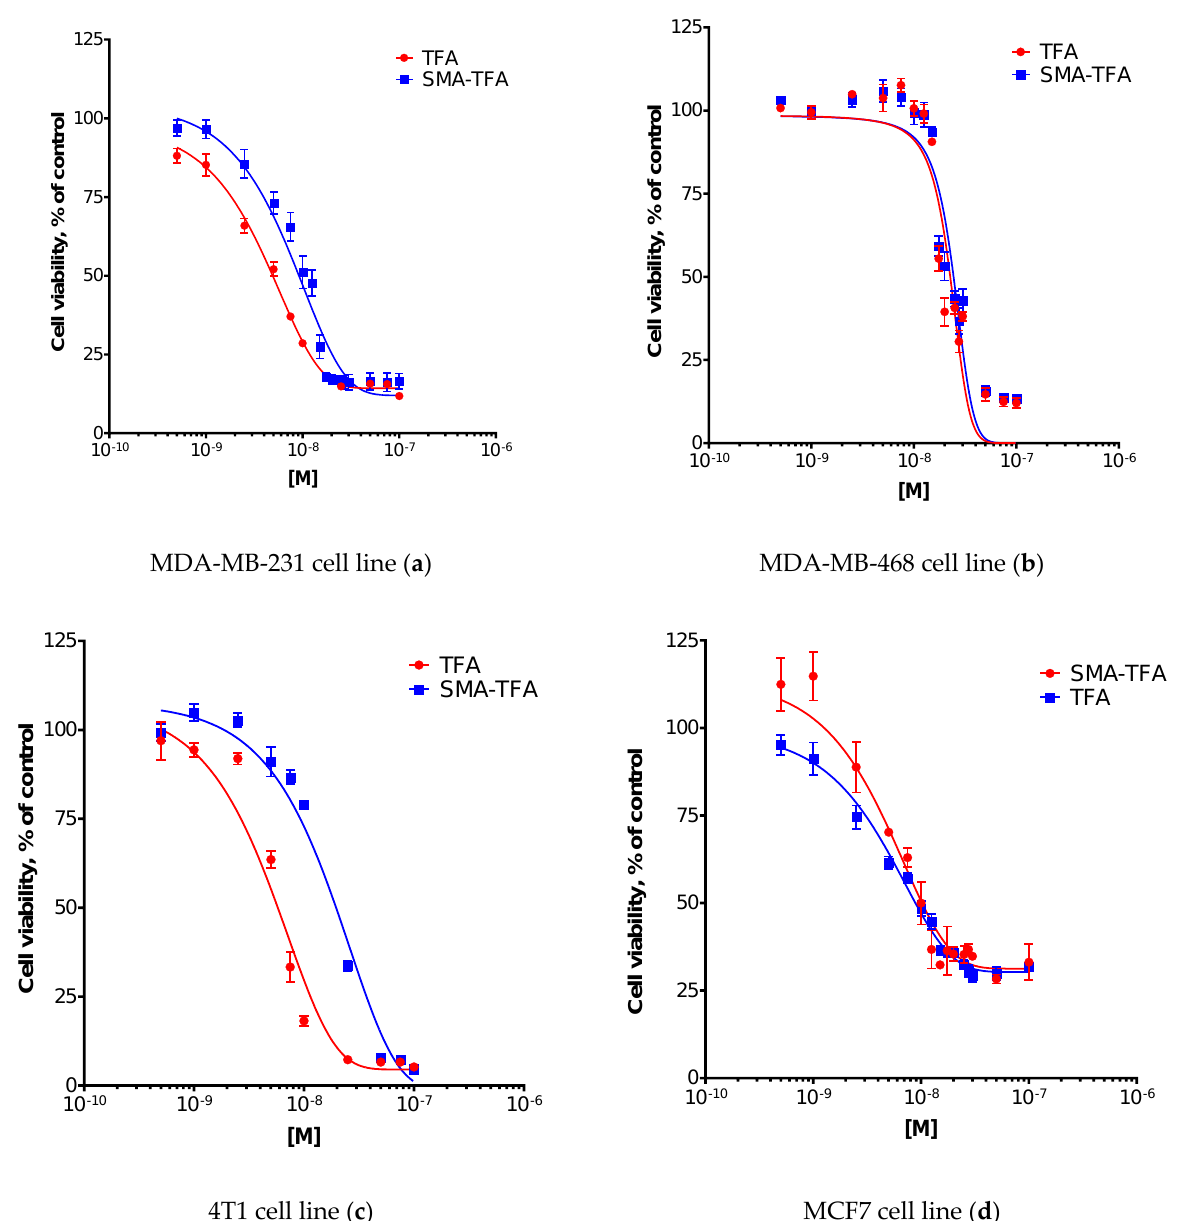
Figure 3. Cytotoxicity of TFA and SMA – TFA ( a ) against MDA-MB-231, ( b ) MDA-MB-468, ( c ) 4T1, and ( d ) MCF7 cells. The cells were treated for 72 h with specific concentrations of TFA and SMA – TFA micelles. The cell number was determined using the SRB assay. Data are expressed as the mean ± SEM ( n = 3). Table 2. Experimental IC 50 values (nM) of free TFA and SMA – TFA towards human MDA-MB-231,